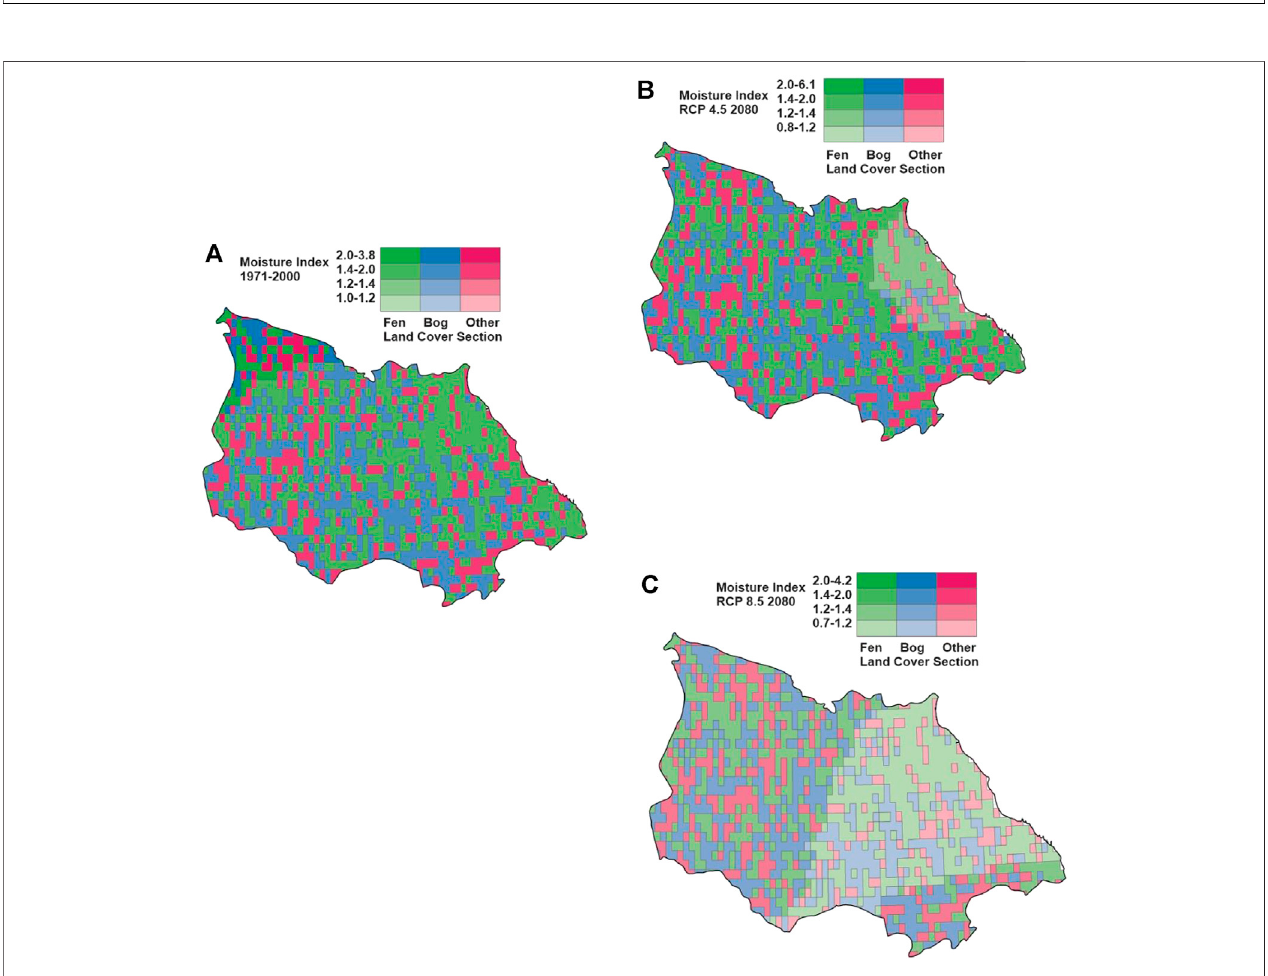
FIGURE 6 | Bivariate maps for the 74,300 km 2 study area for land cover baseline (A) , the 2080s for RCP4.5 (B) , and RCP8.5 (C) .